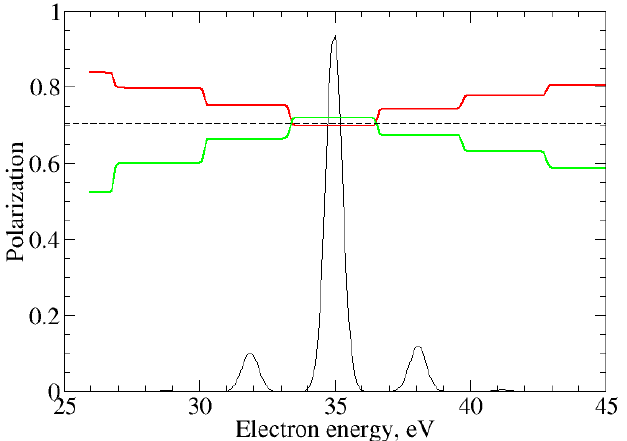
Figure 3. The same as in Figure 1 but for the XUV photon energy 48.4 eV (the photoelectron energy without optical field is 35 eV) and the OP intensity is 1.0 polarized OP, green line—right circularly polarized OP.